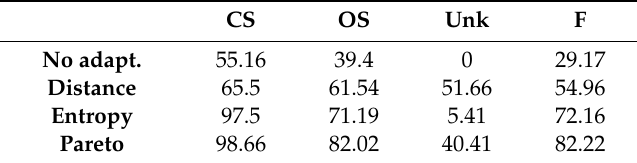
Table 5. Classification results obtained for the scenario Trento → Vaihingen.